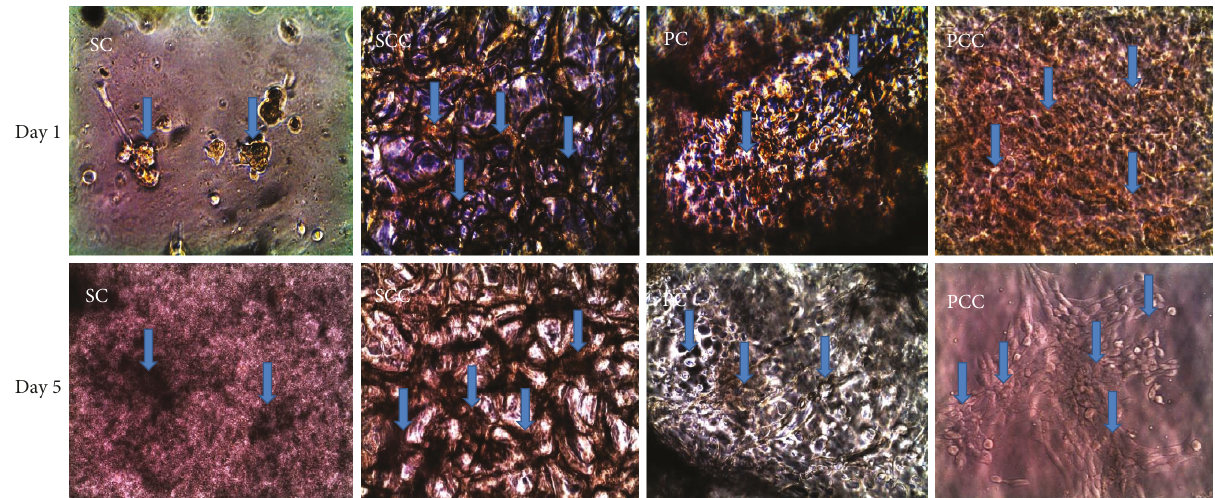
Figure 4: Cell adhesion and proliferation of fi broblast cells, cultured on simple chitosan (SC), simple chitosan composite (SCC), porous chitosan (PC), and porous chitosan composite (PCC) membranes on day 1 and day 5 (the cells are indicated by arrows). Day 5 image shows increased cell growth and adhesion on SCC compared to SC membrane and remarkable cell attachment and spreading on PCC composites in comparison to PC membranes. Images were taken at 100x.